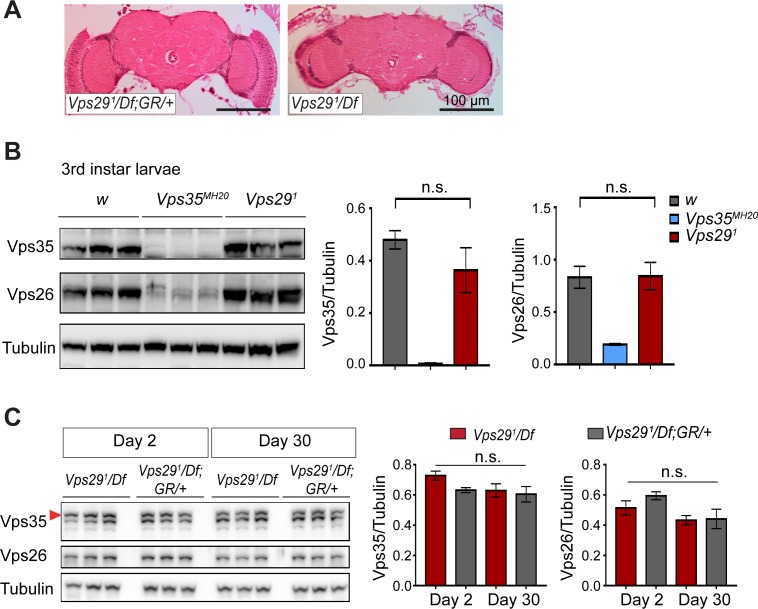
Loss of Vps29 does not affect Vps35 or Vps26 protein expression.(A) Preserved adult brain histology in aged animals lacking Vps29. Hematoxylin and eosin stained frontal sections from 45-day-old Vps291/Df or control animals (Vps291/Df; GR/+) demonstrate no overt neuropathology in the central brain complex. Note that the retina and lamina are absent from frontal sections prepared from Vps29 mutants due to severe degeneration of these structures. See also Figure 1—figure supplement 1B. (B) Vps35 and Vps26 protein levels are normally expressed in Vps291 homozygous third instar larvae but absent or reduced, respectively, in Vps35MH20 homozygotes. Western blots were probed for Vps35, Vps26, and Tubulin (loading control), and quantified based on n = 3 replicate experiments. For statistical analysis, a Student’s t-test was performed. (C) Vps35 and Vps26 proteins are normally expressed in Vps291/Df animals. Adult fly head homogenates were prepared from 2-day-old or 30-day-old Vps291/Df or control animals (Vps291/Df; GR/+). Western blots were probed for Vps35, Vps26, and Tubulin (loading control), and quantified based on n = 3 replicate experiments. For statistical analysis, one-way ANOVA was performed. Red arrowhead denotes the Vps35-specific band. All error bars denote SEM. n.s., not significant.